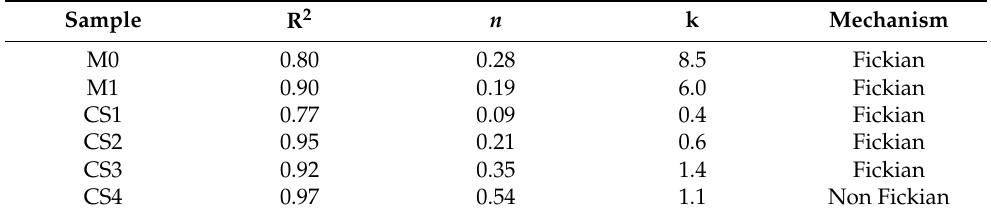
Table 3. Correlation of the triclosan release kinetics of electrospun nanofibers with Korsmeyer-Peppas model and corresponding